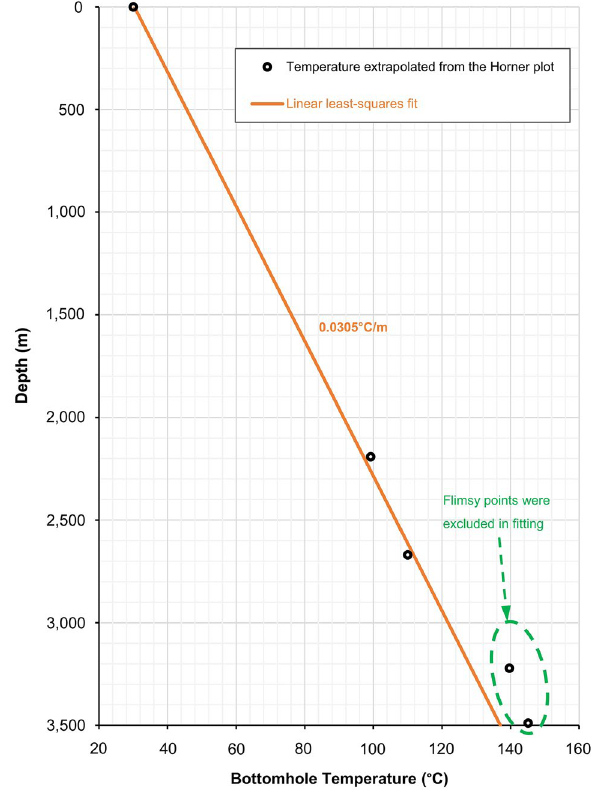
Fig. 5 Formation temperature gradient from corrected bottom-hole temperature (BHT). Flimsy BHT was extrapolated using two-point datasets. The gradient without flimsy points is 0.0305 °C/m and